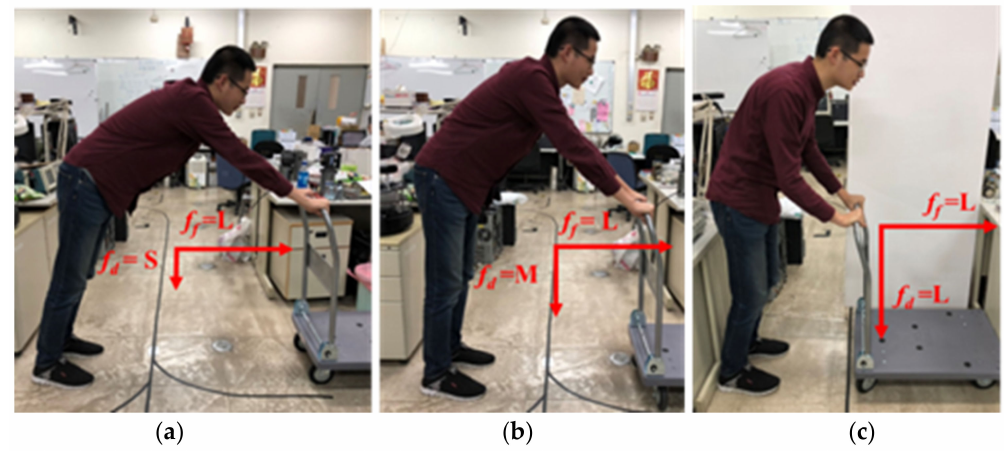
Figure 10. Posture judgment ( f f = L): ( a ) f d = S; ( b ) f d = M; ( c ) f d = L.